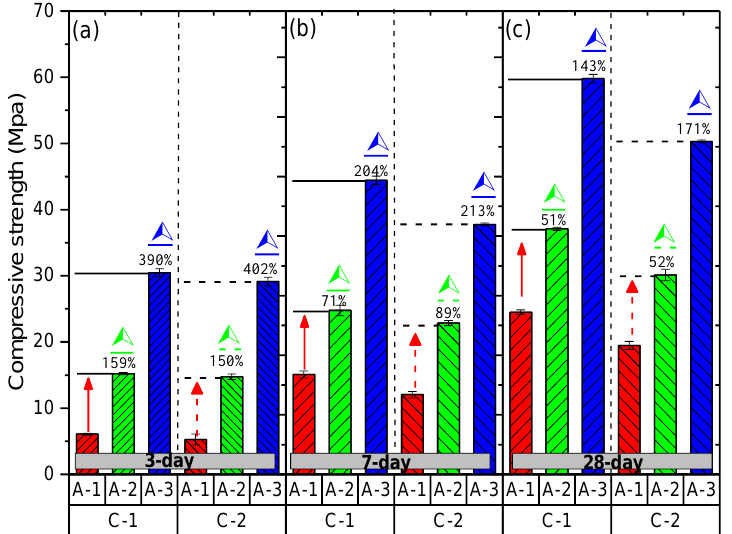
Figure 7. Compressive strength of samples with different alkaline activators under two curing conditions: ( a ) 3 days, ( b ) 7 days and ( c ) 28 days. ( (cid:227) indicates the increases value of compressive strength compared with A-1# samples).